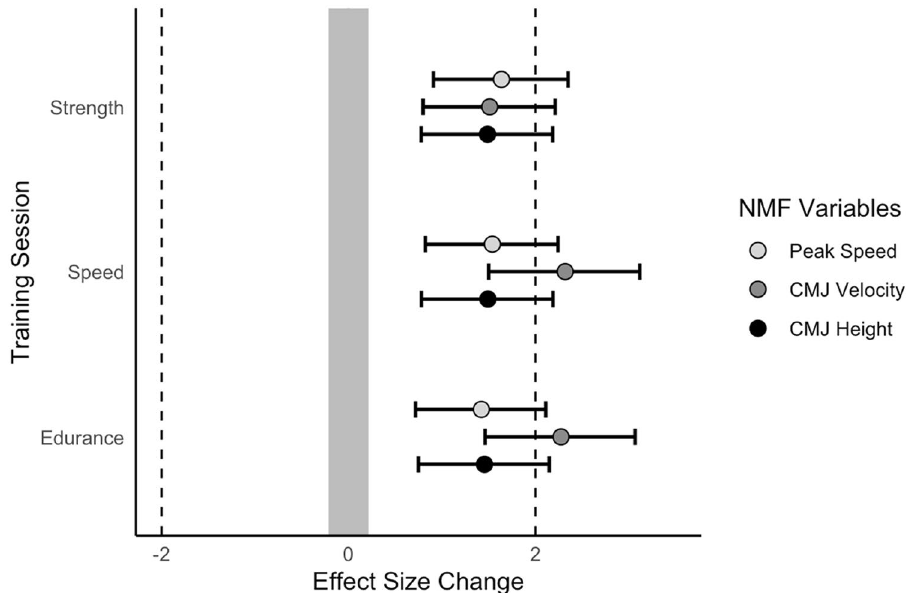
Figure 1. Effect size change between pre- and post-test neuromuscular fatigue variables. Grey = smallest important effect size (0.20) both positively and negatively. NMF; neuromuscular fatigue, CMJ; countermovement jump.